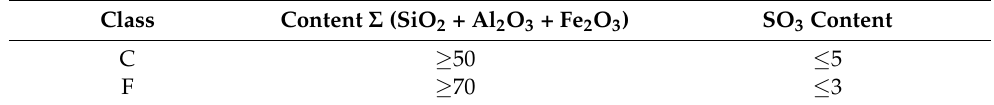
Table 1. Classification of fly ash according to ASTM C618 (%). Class Content Σ (SiO 2 + Al 2 O 3 + Fe 2 O 3 ) SO 3 Content C ≥ 50 ≤ 5 F ≥ 70 ≤